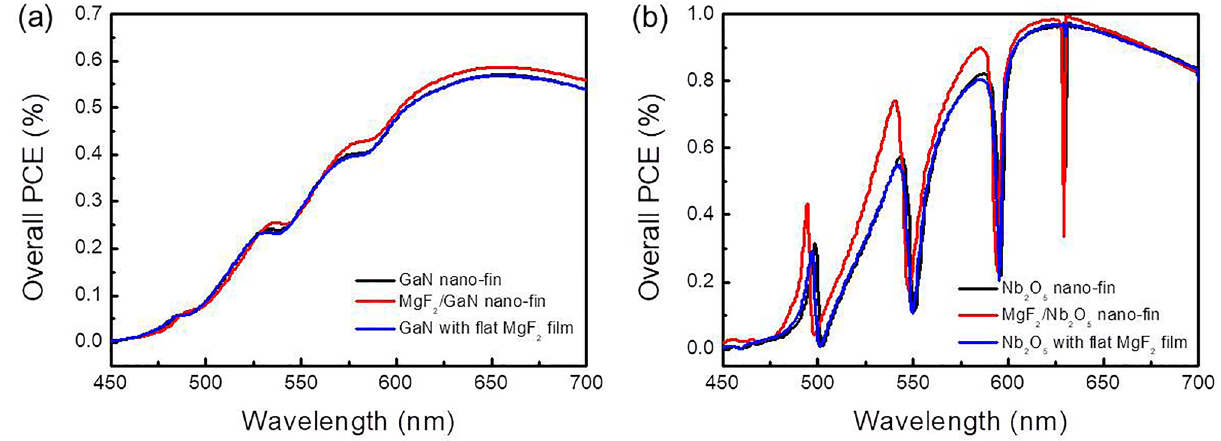
Figure 8. Simulation results of overall PCE spectra. ( a ) GaN nano-fin and flat MgF 2 film thickness are 950 nm and 140 nm, respectively. In the hetero-nano-fin case, GaN and MgF 2 thickness is 950 nm and 140 nm. ( b ) For the case of flat MgF 2 film, the thickness of Nb 2 O 5 nano-fin and flat MgF 2 film is 1000 nm and 140 nm, respectively. In the hetero-nano-fin case,